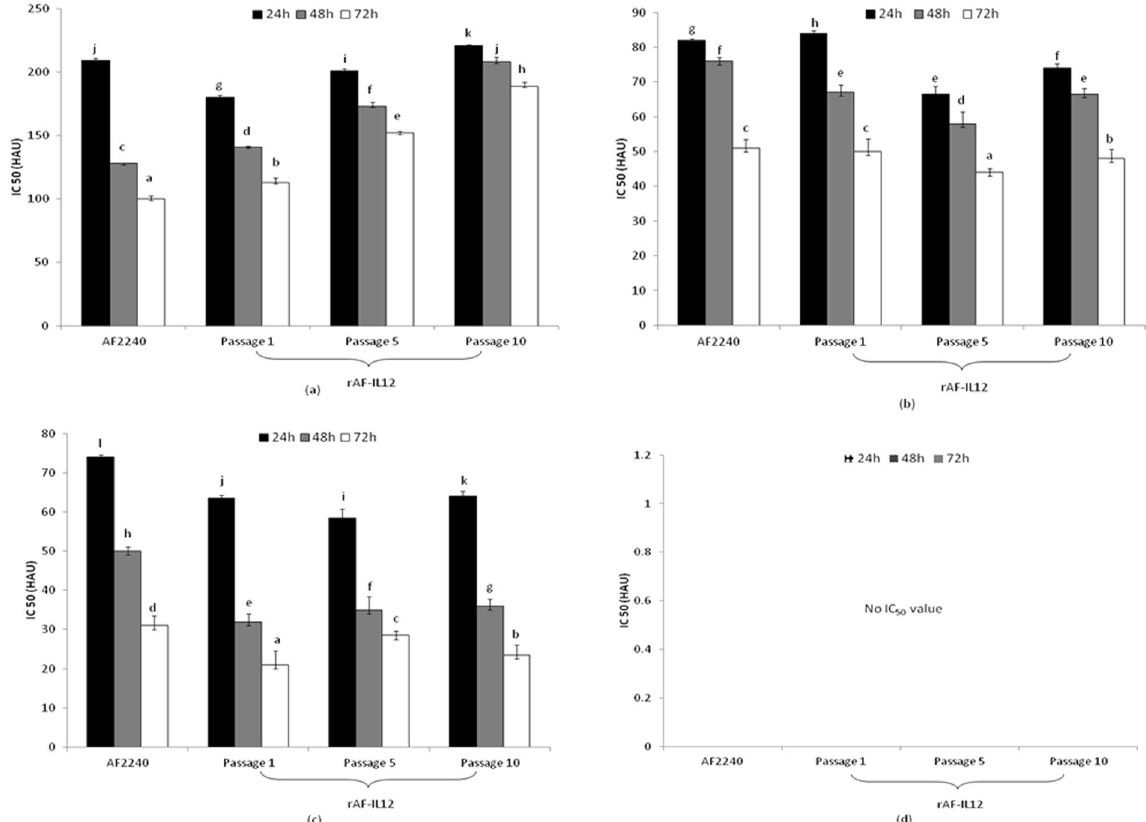
Figure 1. Cytotoxic effects of rAF-IL12 and the parental strain AF2240 against: ( a ) DF-1; ( b ) MDA-MB231; ( c ) MCF-7 and; ( d ) MCF-10A at 24, 48 and 72 h post-inoculation. The values are expressed as the mean values ± standard deviation of triplicate experiments. The mean values as indicated using different superscript letters were significantly different at p < 0.05 when compared between parental AF2240- and rAF-IL12 (Passages 1, 5 & 10)-treated